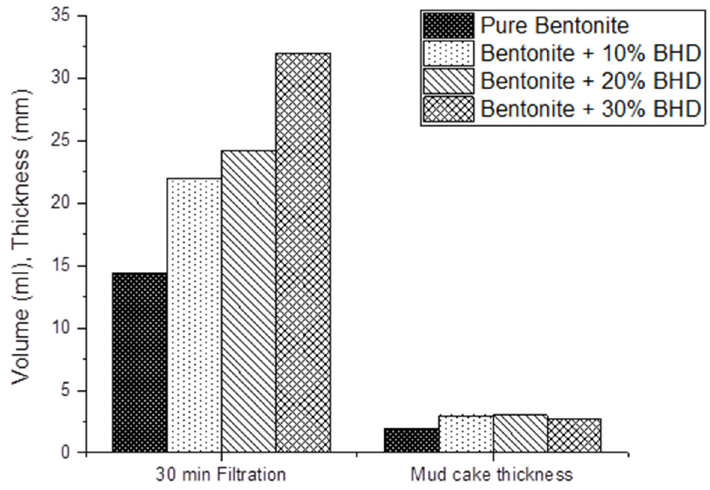
Figure 11. API filtration test for different ratios of steel dust (BHD) and bentonite.